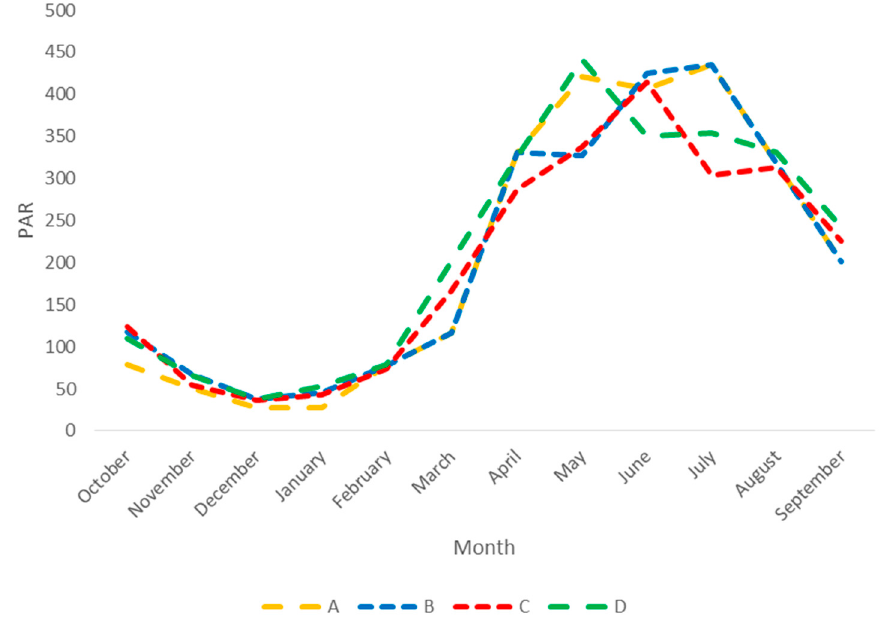
Figure 4. Average monthly PAR values for the four PAR scenarios collated from measurements made between 2004 and 2014 at the Queen’s University Marine Laboratory in Portaferry, Northern Ireland. NB: PAR in the model are provided at an hourly rate, data not shown.